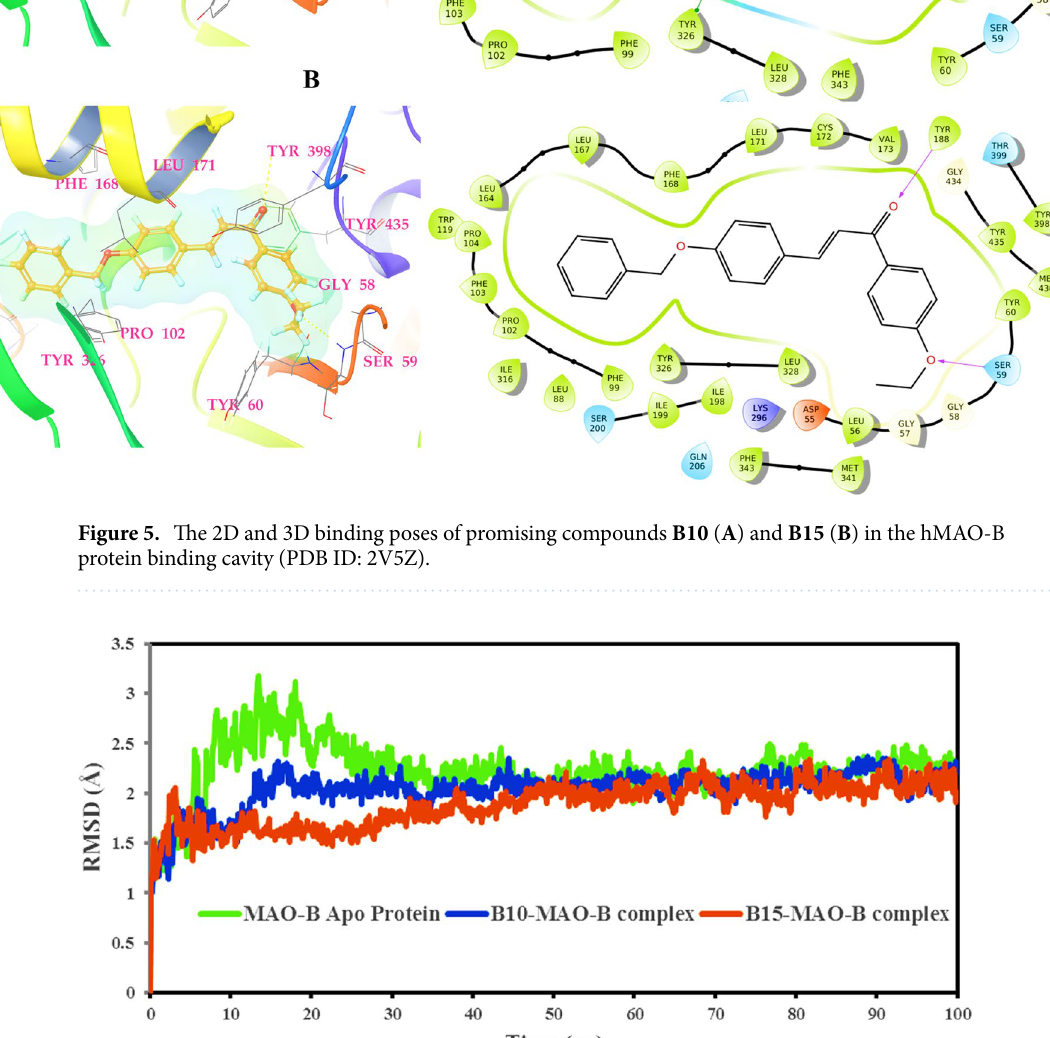
Figure 6. RMSD of the time-dependent hMAO-B protein backbone in complex with compound B10 (blue) and B15 (red) during 100 ns